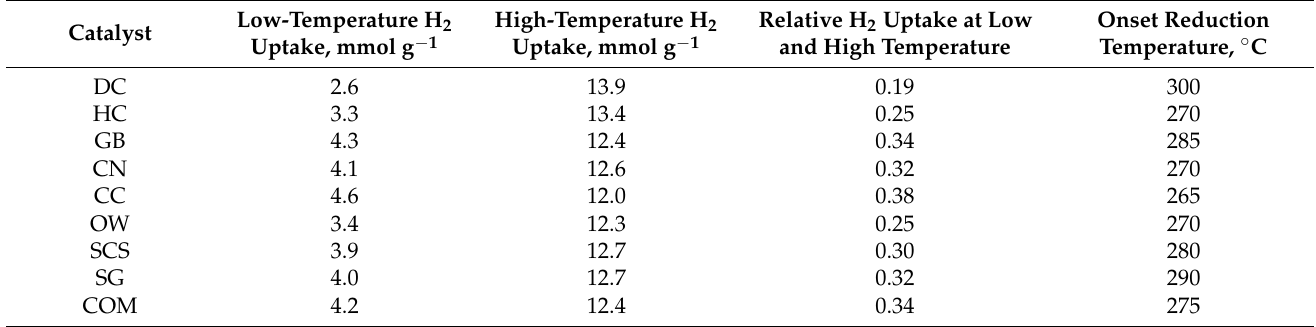
Table 3. Results of the H 2 -TPR analysis of the bulk Co 3 O 4